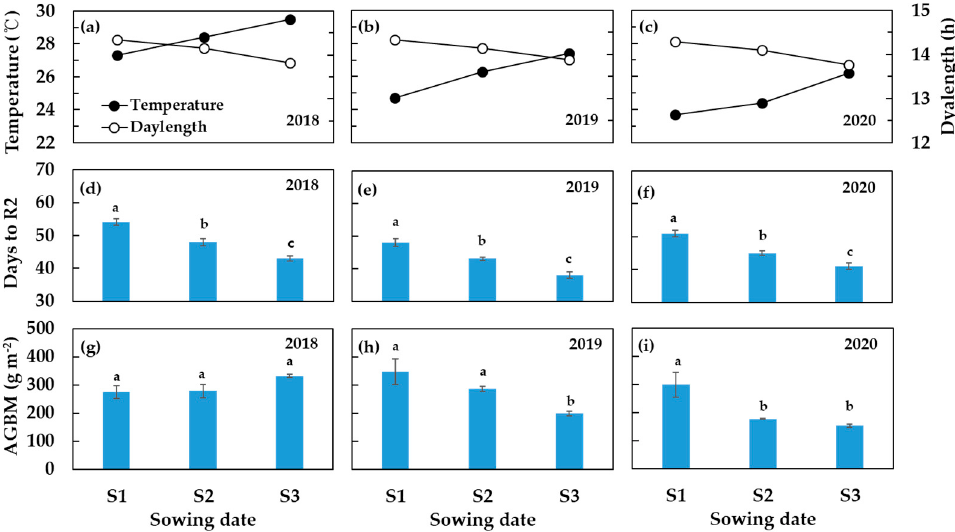
Figure 3. Effects of sowing dates on growth temperature ( a – c ), day-length ( a – c ), days to R2 ( d – f ), and aboveground biomass (AGBM) accumulation at R2 ( g – i ) of double-crop soybean grown in drained paddy fields over three years (2018–2020). R2 refers to flowering. S1, S2, and S3 refer to sowing date on 10–15 June, 25–30 June, and 10–15 July, respectively. Different letters above columns indicate statistically significant differences ( p < 0.05). Vertical bars indicate standard errors.